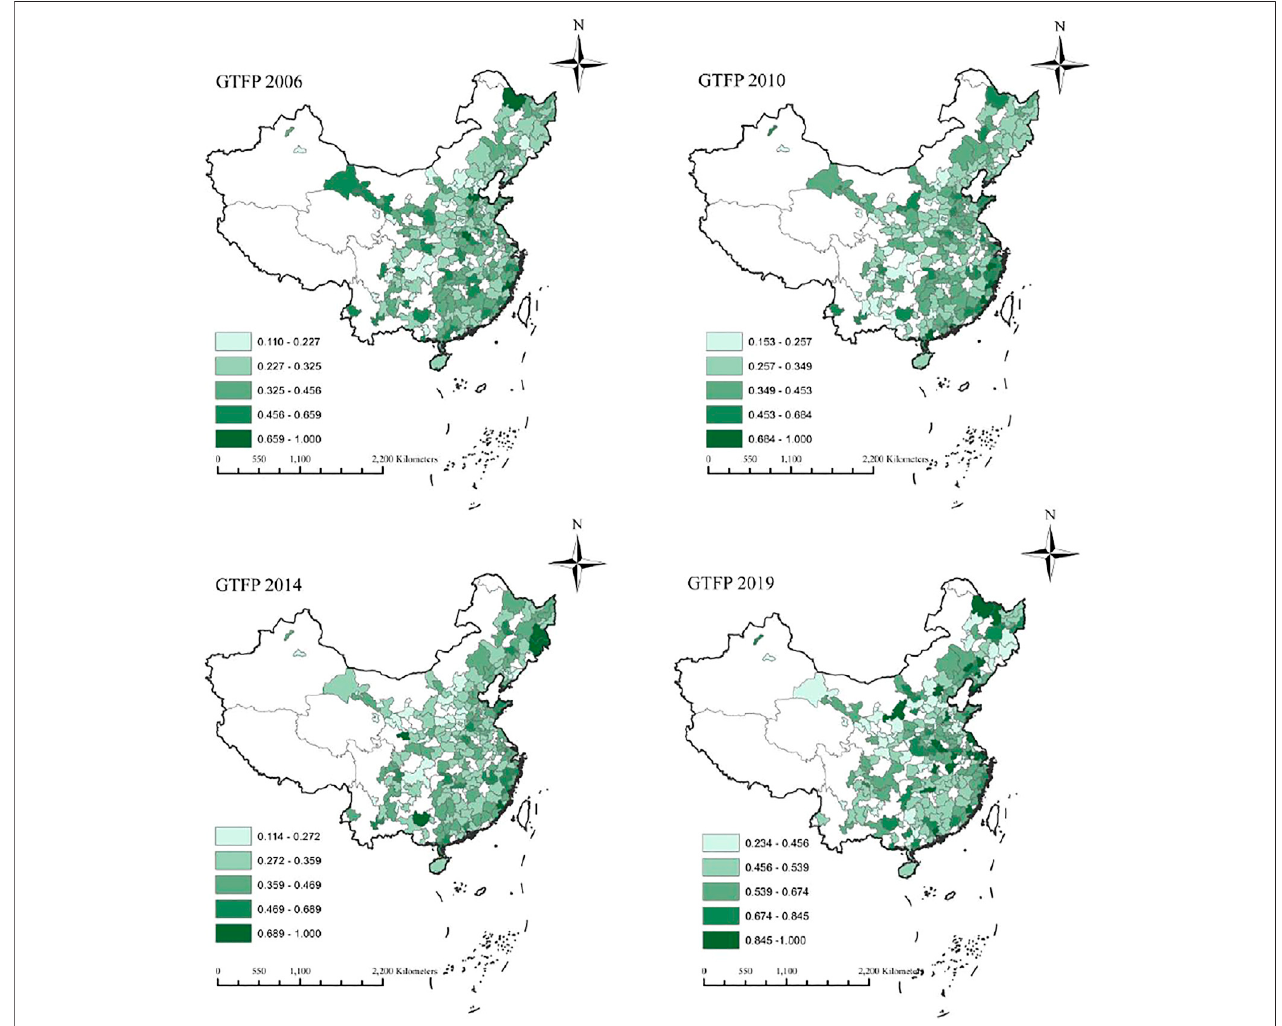
FIGURE 2 | Spatial distribution map of